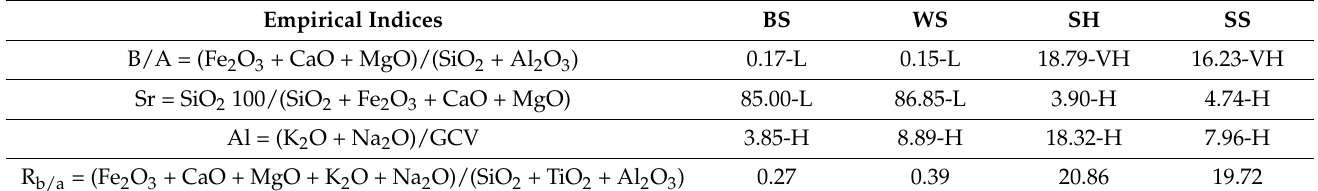
Table 4. Tendency of biomass fuel slagging.